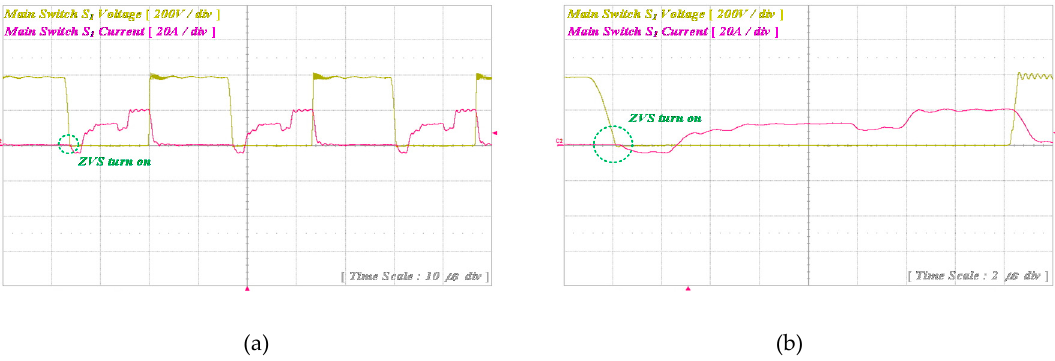
Figure 20. ( a ) Waveforms of main switch S 1 voltage and current and ( b ) expansion waveforms of S 1.